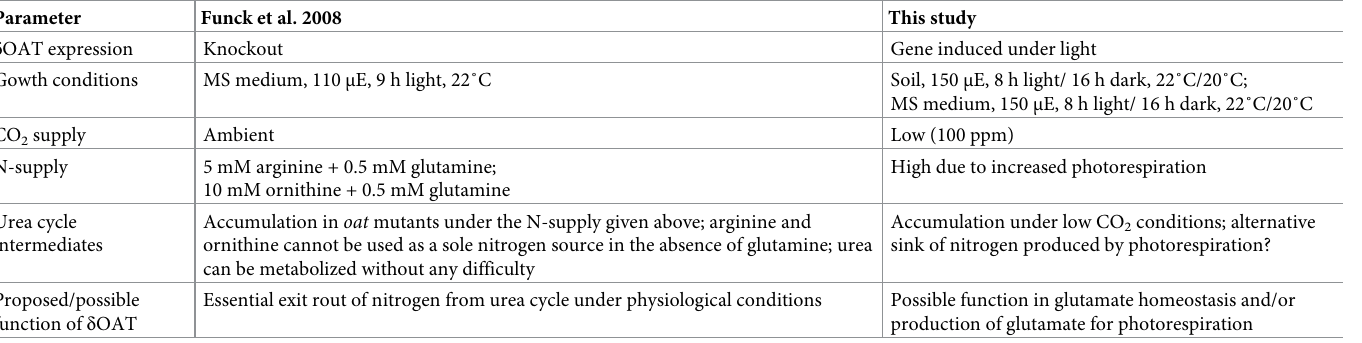
Table 3. Comparison of the experimental setup and parameters in Funck et al. [5] and our study.